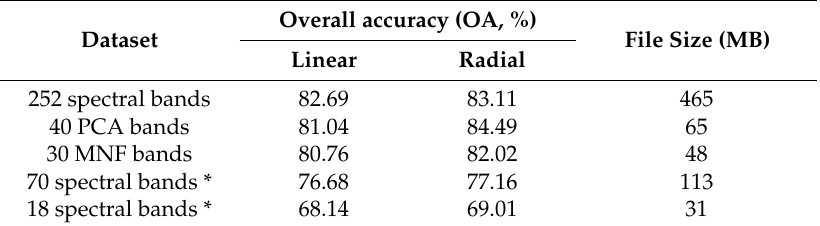
Table 2. Overall accuracies obtained for different datasets and two kernel functions. PCA: Principal Component Analysis; MNF: Minimum Noise